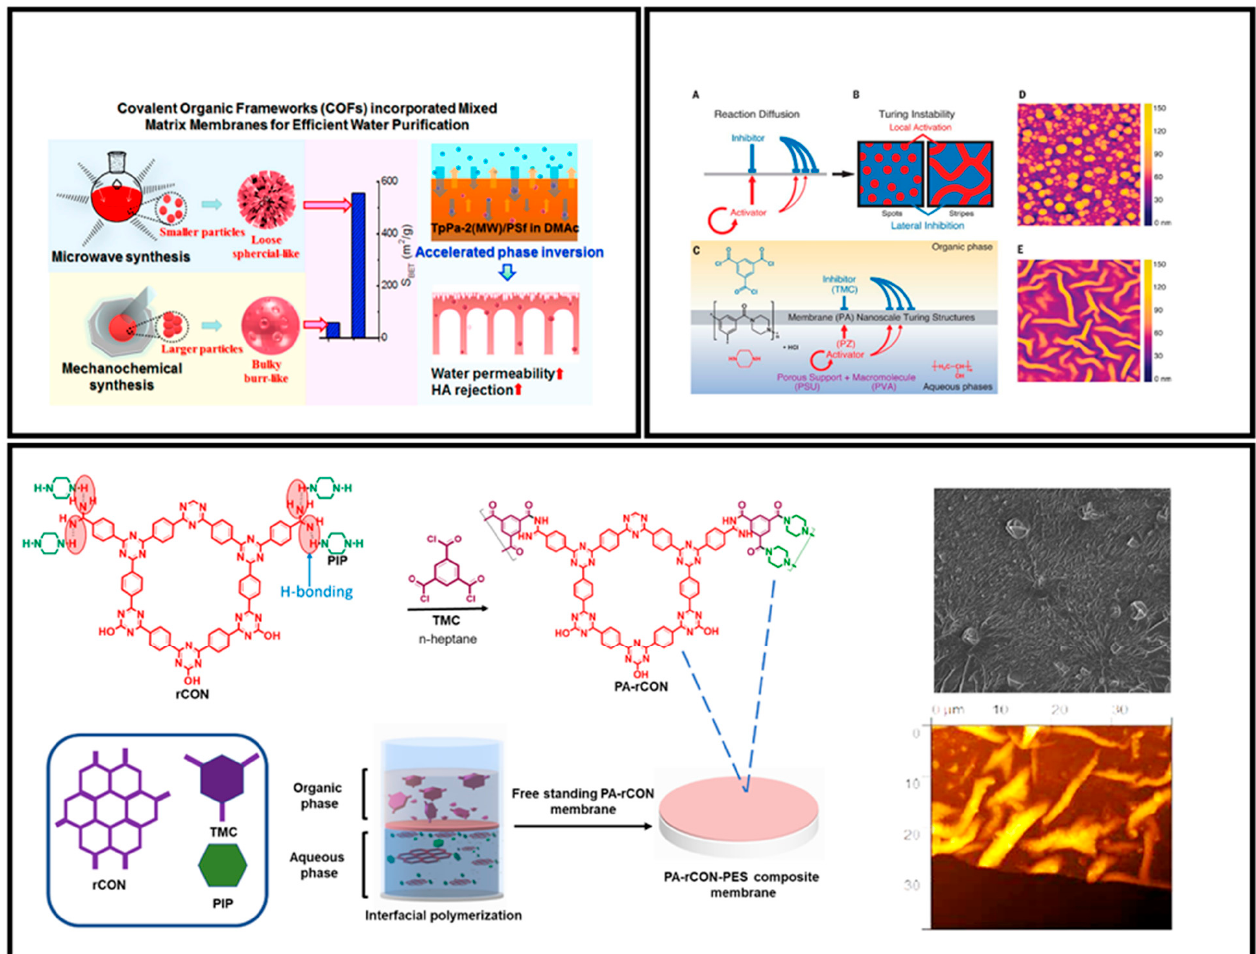
Figure 6. Different strategies to fabricate MMMs. Adapted with permission from reference [80] copyright 2020 American Chemical Society and [150] copyright 2018 Science..